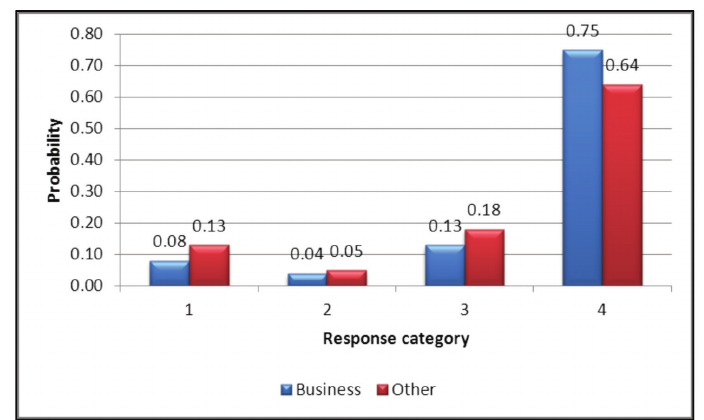
Figure 2: Response category probabilities – Ease of access (purpose of travel)